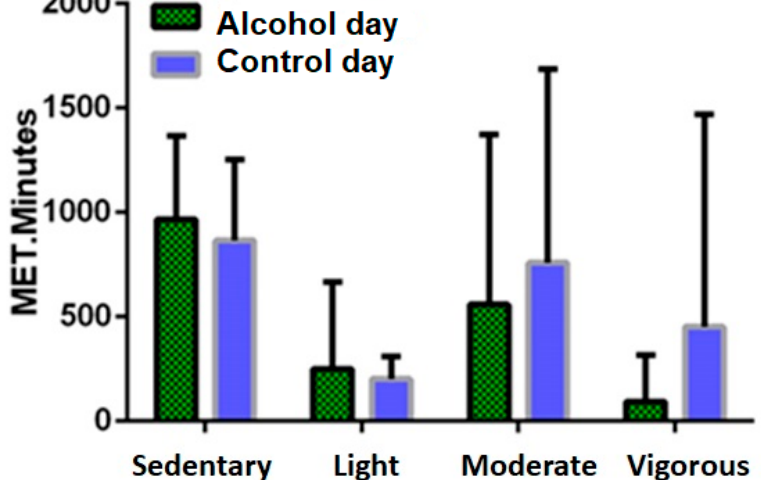
Figure 4. MET.minutes for different physical activity levels on the alcohol day and control day.